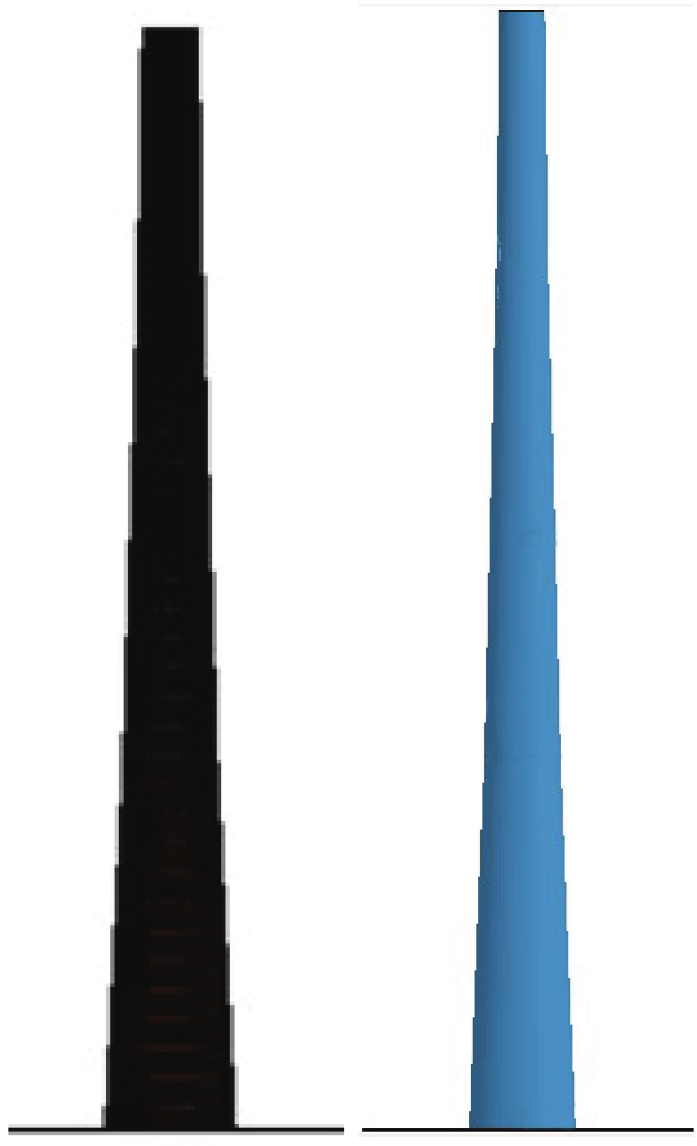
Figure 12: Finite element model of reinforced concrete chimney.